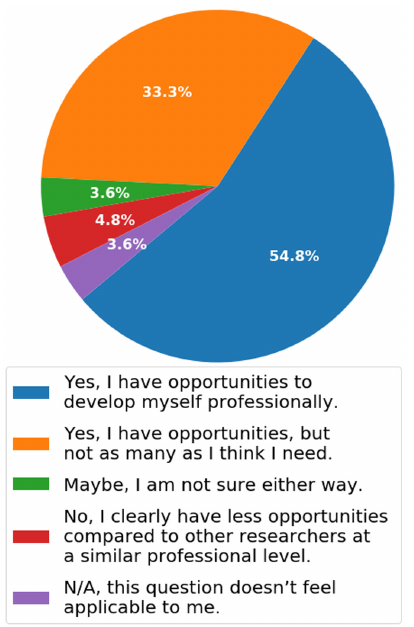
Figure 12. Bar chart representing answers to Q2.8. Data was pooled from across job descriptions for this question. Participants were able to select multiple answers.